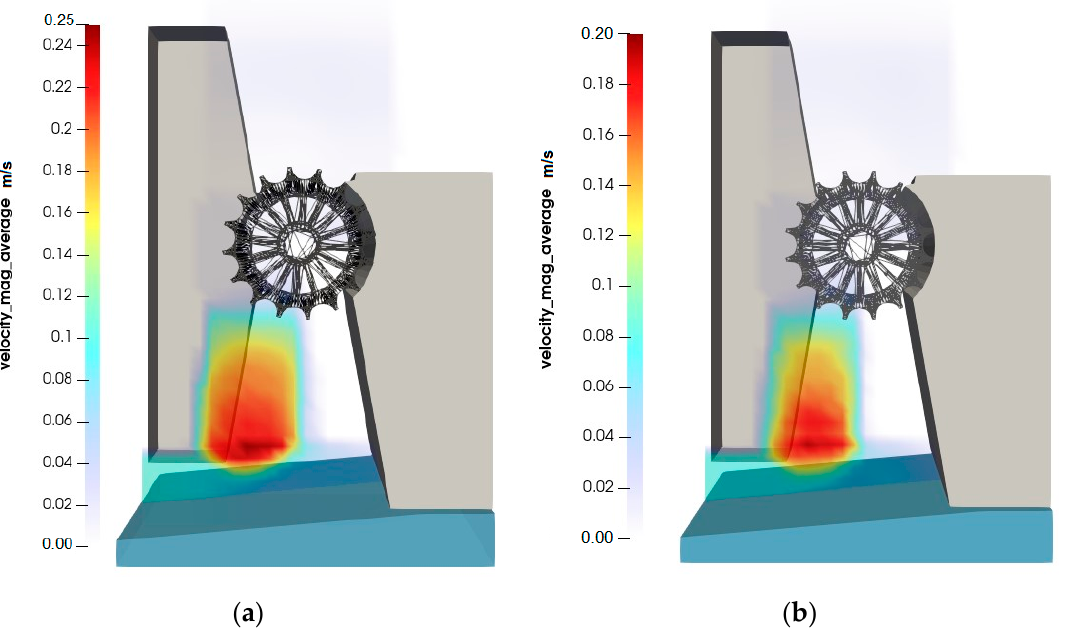
Figure 10. Average velocities over time for ( a ) the noncohesive and ( b ) cohesive materials.